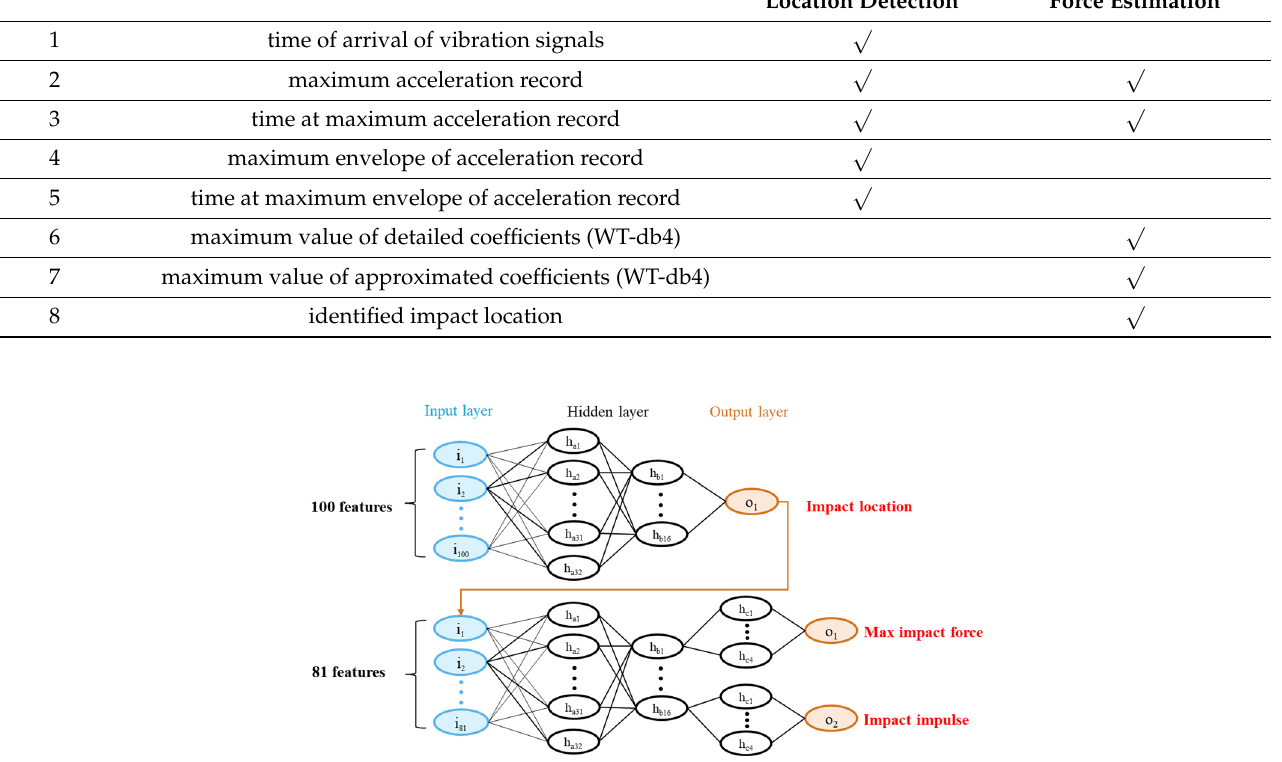
Figure 8. Artificial neural network architecture for impact force estimation.